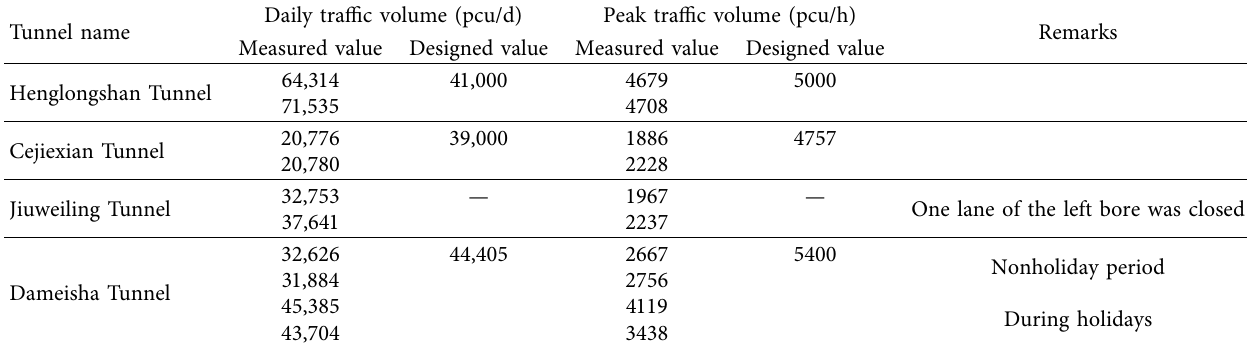
Table 2: Traffic survey results of the four